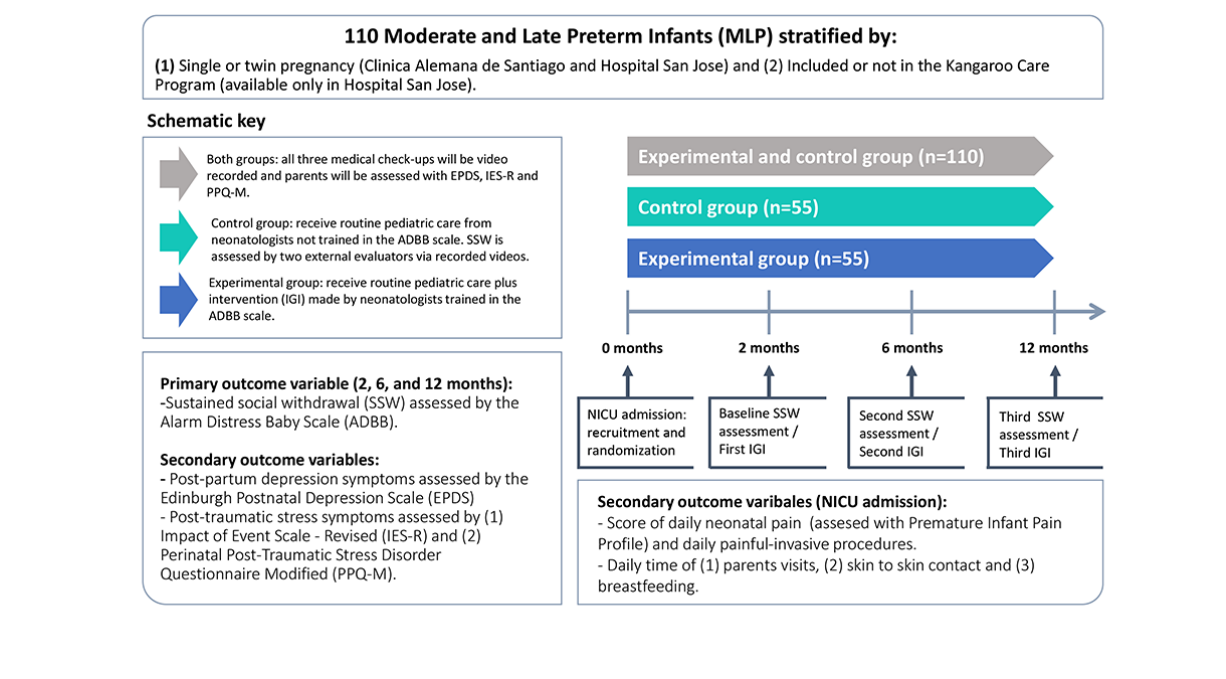
Figure 1. Interactive Guidance Intervention plan for infants born moderately or late preterm with primary and secondary outcome variables recorded during NICU admission and during medical checkups at 2, 6, and 12 months of corrected age. ADBB: Alarm Distress Baby scale; EPDS: Edinburgh Postnatal Depression scale; IES-R: Impact of Event scale–revised; IGI: Interactive Guidance Intervention; NICU: neonatal intensive care; PPQ-M: modified Perinatal Posttraumatic Stress Disorder Questionnaire; SSW: sustained social